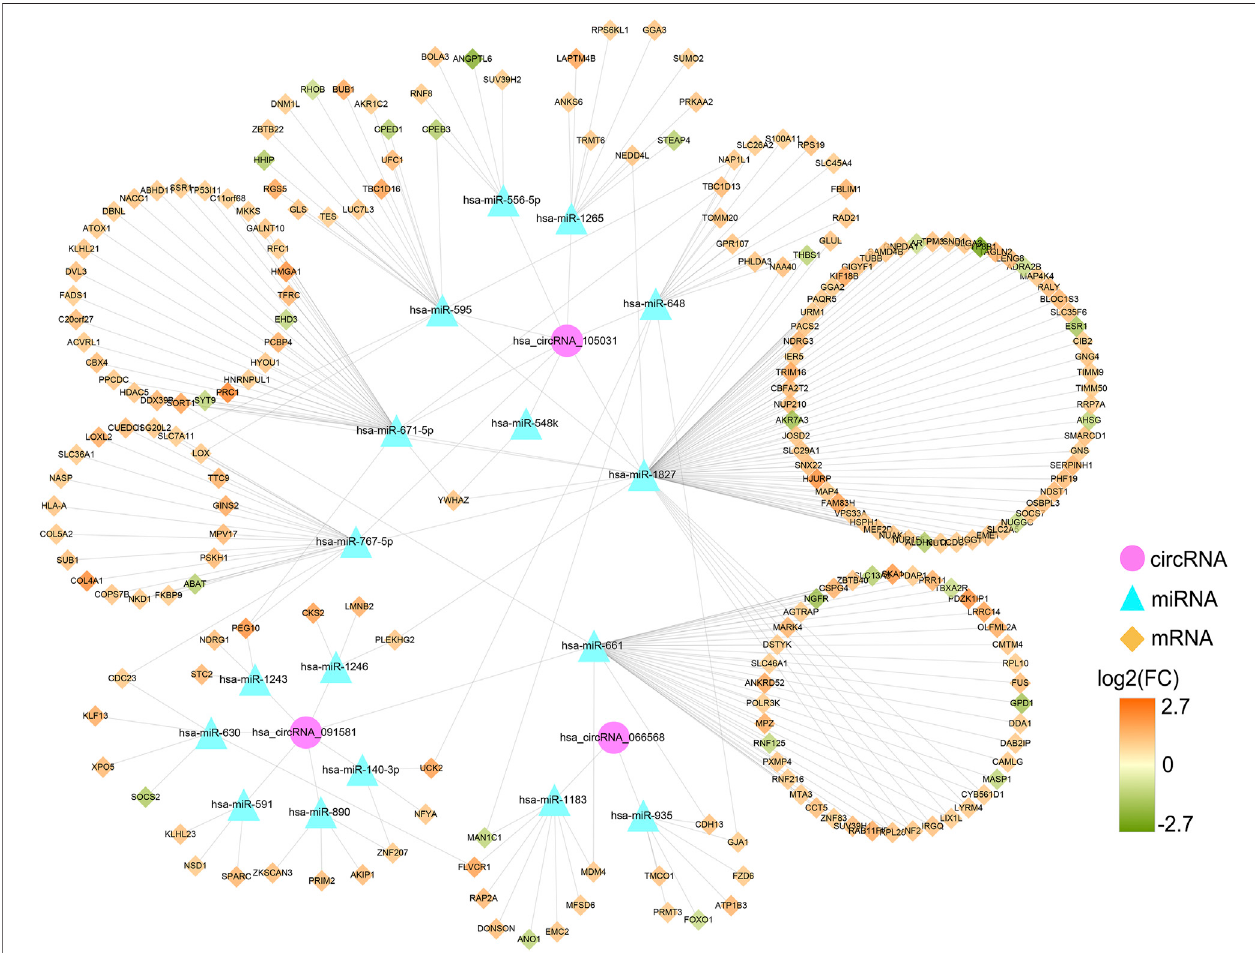
FIGURE 8 | Preliminary circRNA-miRNA-mRNA regulatory network in HCC. The network, consisting of three circRNAs, 17 miRNAs, and 222 mRNAs, was visualized by the Cytoscape software (3.8.3). HCC, hepatocellular carcinoma.